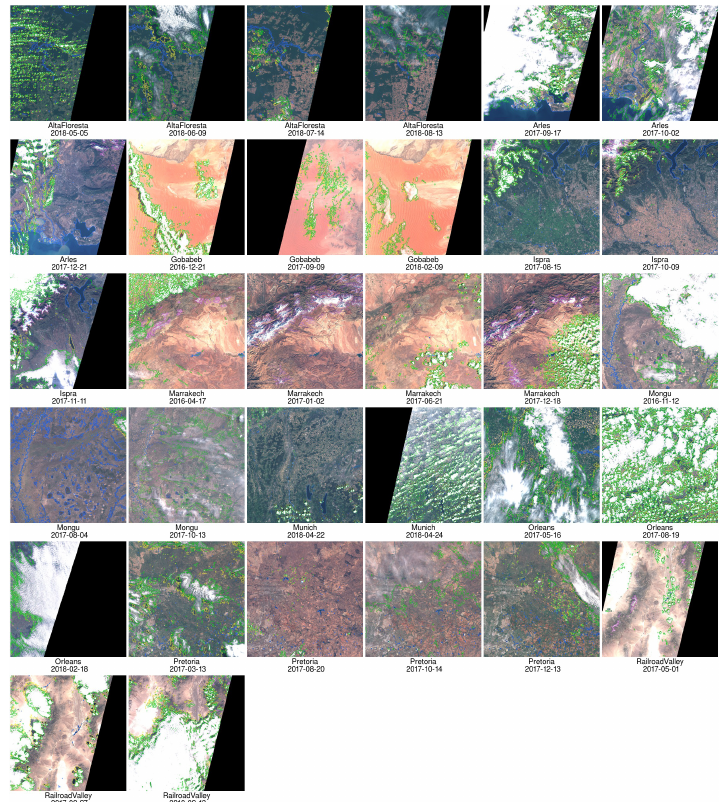
Figure 4. Miniatures of the 32 reference cloud masks generated in the study, with contours provided as in Figure 3. This figure is provided to show the diversity of landscapes and cloud covers. Larger images are provided in the Supplementary Material with this